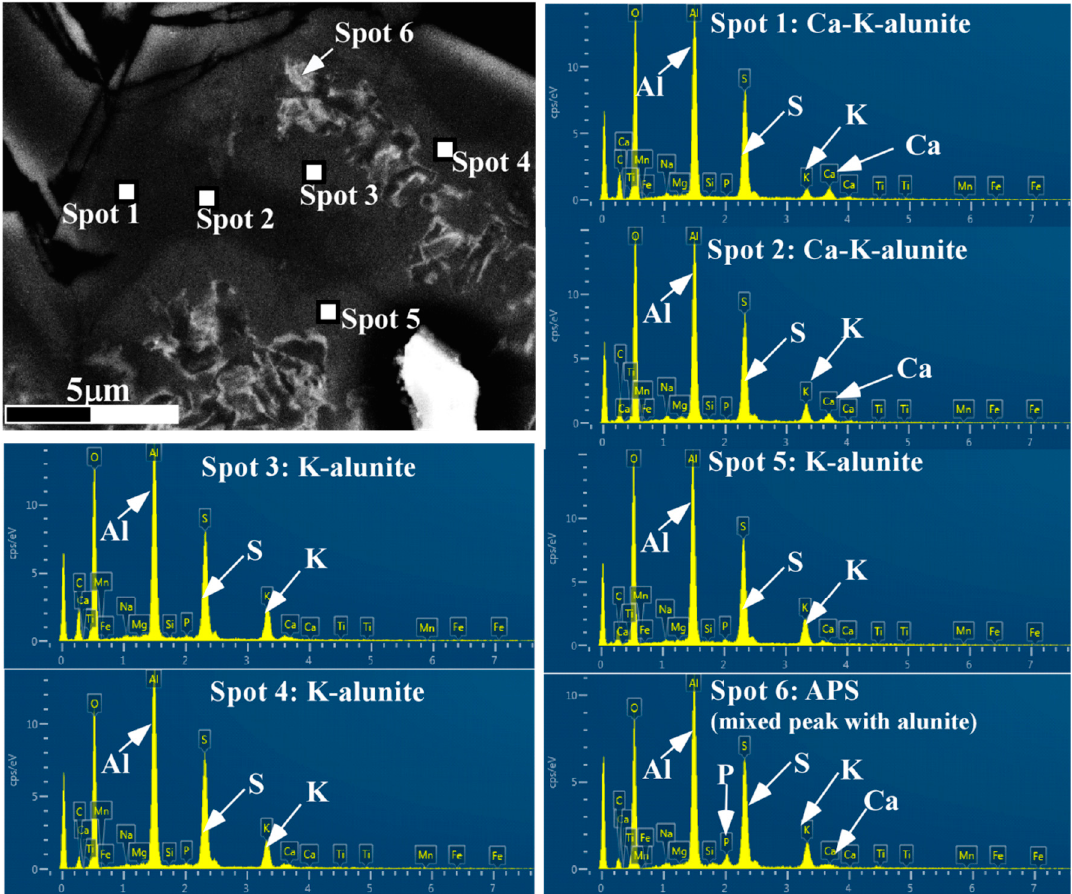
Figure 3. Compositionally zoned alunite containing a core of a dissolved-fibrous APS mineral. Table 1. Endmember compositions of aluminum-phosphate-sulfates (APS) and alunite.